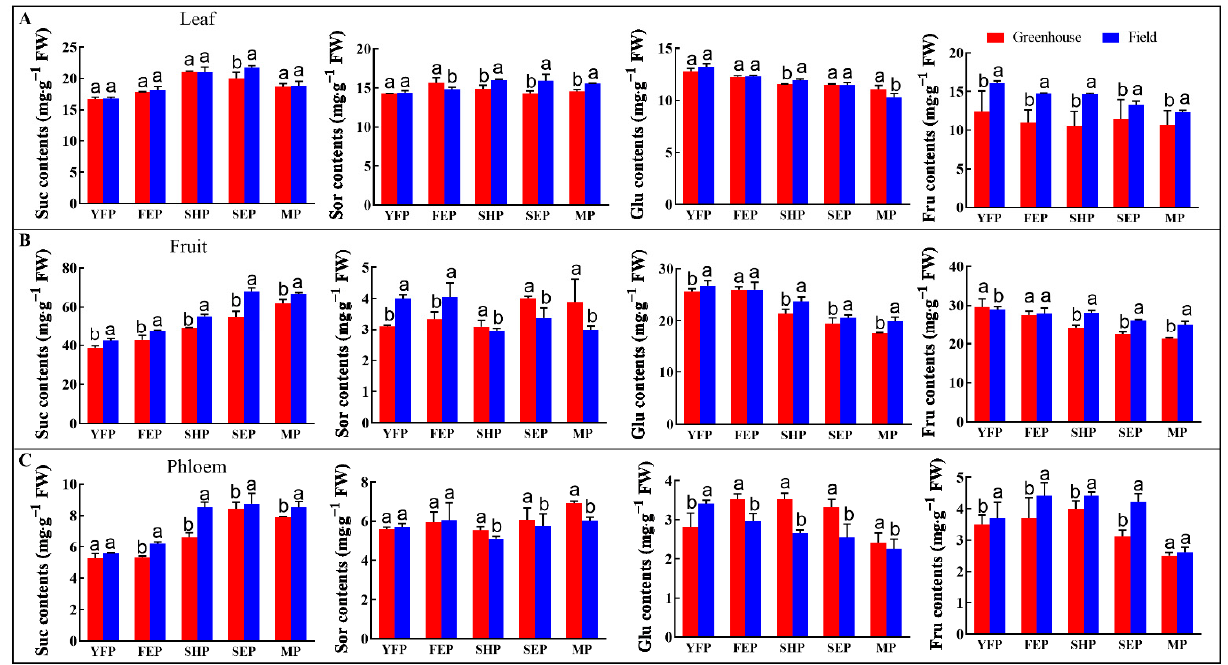
Figure 3. Sugar contents in different parts of peach fruit grown in the field and greenhouse. ( A – C ) show the contents of sugar components in leaves, fruits and phloem, respectively. Sucrose, glucose, fructose and sorbitol are abbreviated as Suc, Glu, Fru and Sor, respectively. The data are presented as the means ± SDs obtained from three biological replicates. Different lowercase letters indicate significance ( p <